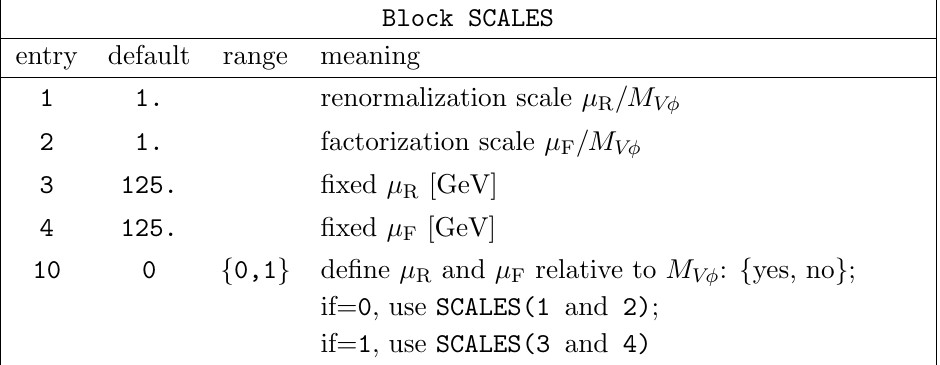
Table 4 . De(cid:12)ning the unphysical scales. M V(cid:30) is the invariant mass of the V(cid:30) system.